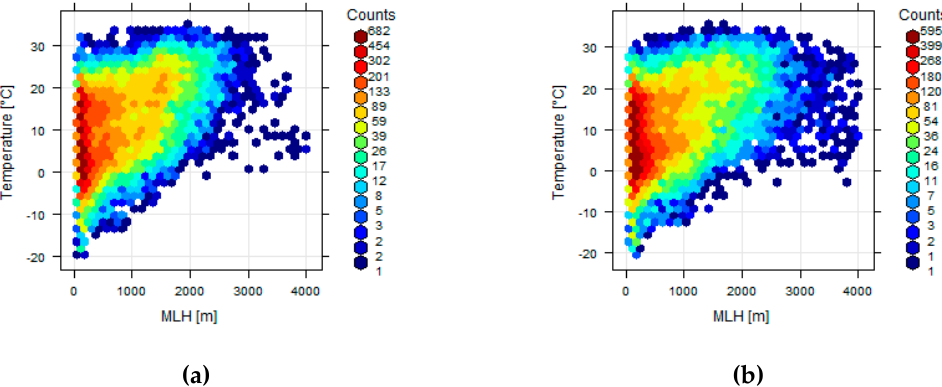
Figure 6. Variation of hourly temperature values in relation to MLH, 2016–2019: ( a ) T ř inec-Kosmos; ( b ) V ěřň ovice.